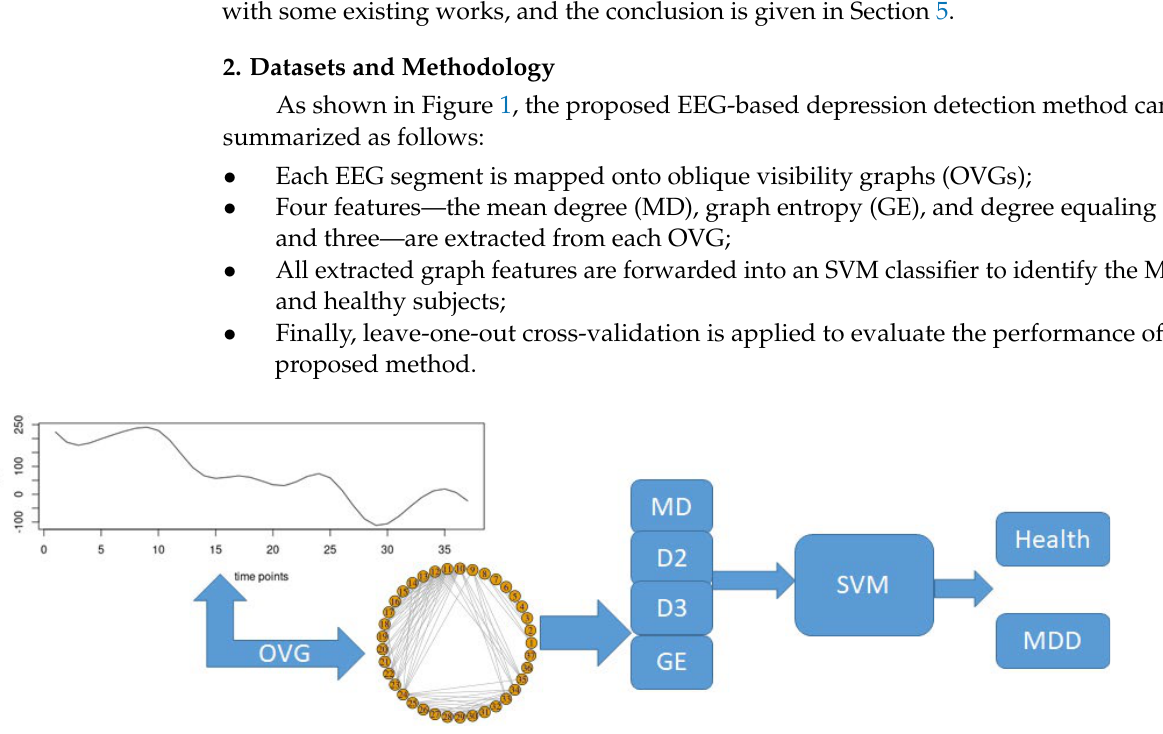
Figure 1. The workflow of the depression classification with EEG signal data, where GE = graph entropy, MD = mean degree, D2 = degree of 2, D3 = degree of 3, GE = graph entropy, and SVM = support vector machine.